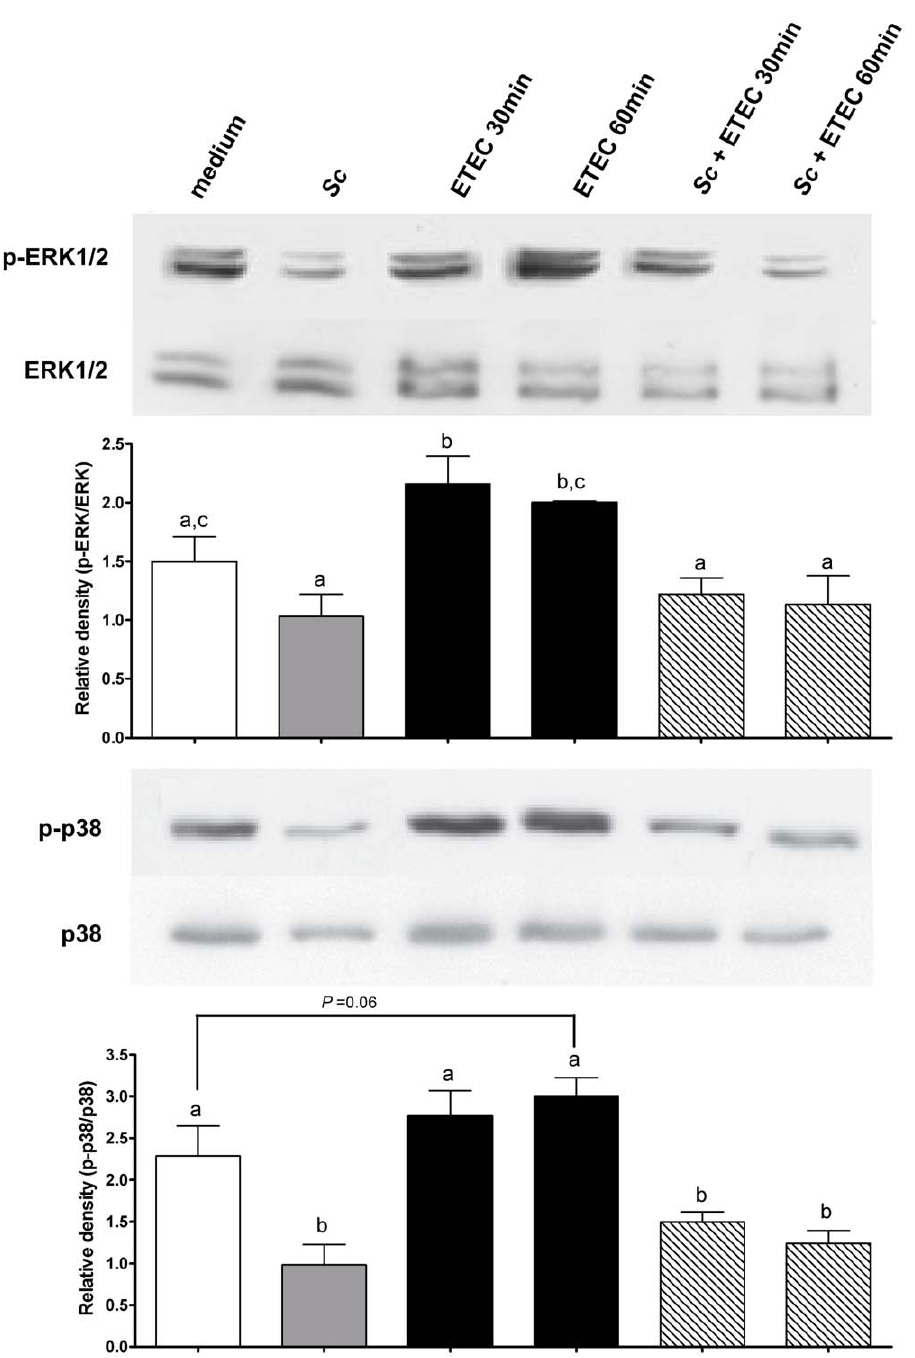
Figure 5. Saccharomyces cerevisiae decreases the MAP Kinase (ERK1/2, p38) phosphorylation in differentiated IPEC-1 cells. Differentiated IPEC-1 cells were exposed for 30 and 60 min with ETEC (3 6 10 7 CFU/well) in the presence and absence of Sc (3 6 10 6 yeasts/well). Western blots for phospho-ERK1/2 (p-ERK1/2) and phospho-p38 (p-p38) were performed. Total ERK1/2 and total p38 are shown as loading controls and did not change with each condition over time. Data are presented as means 6 SEM, ( n =3) and the different letters represent significant differences between the treatments ( P , 0.05 ). Results are representative of three independent experiments.